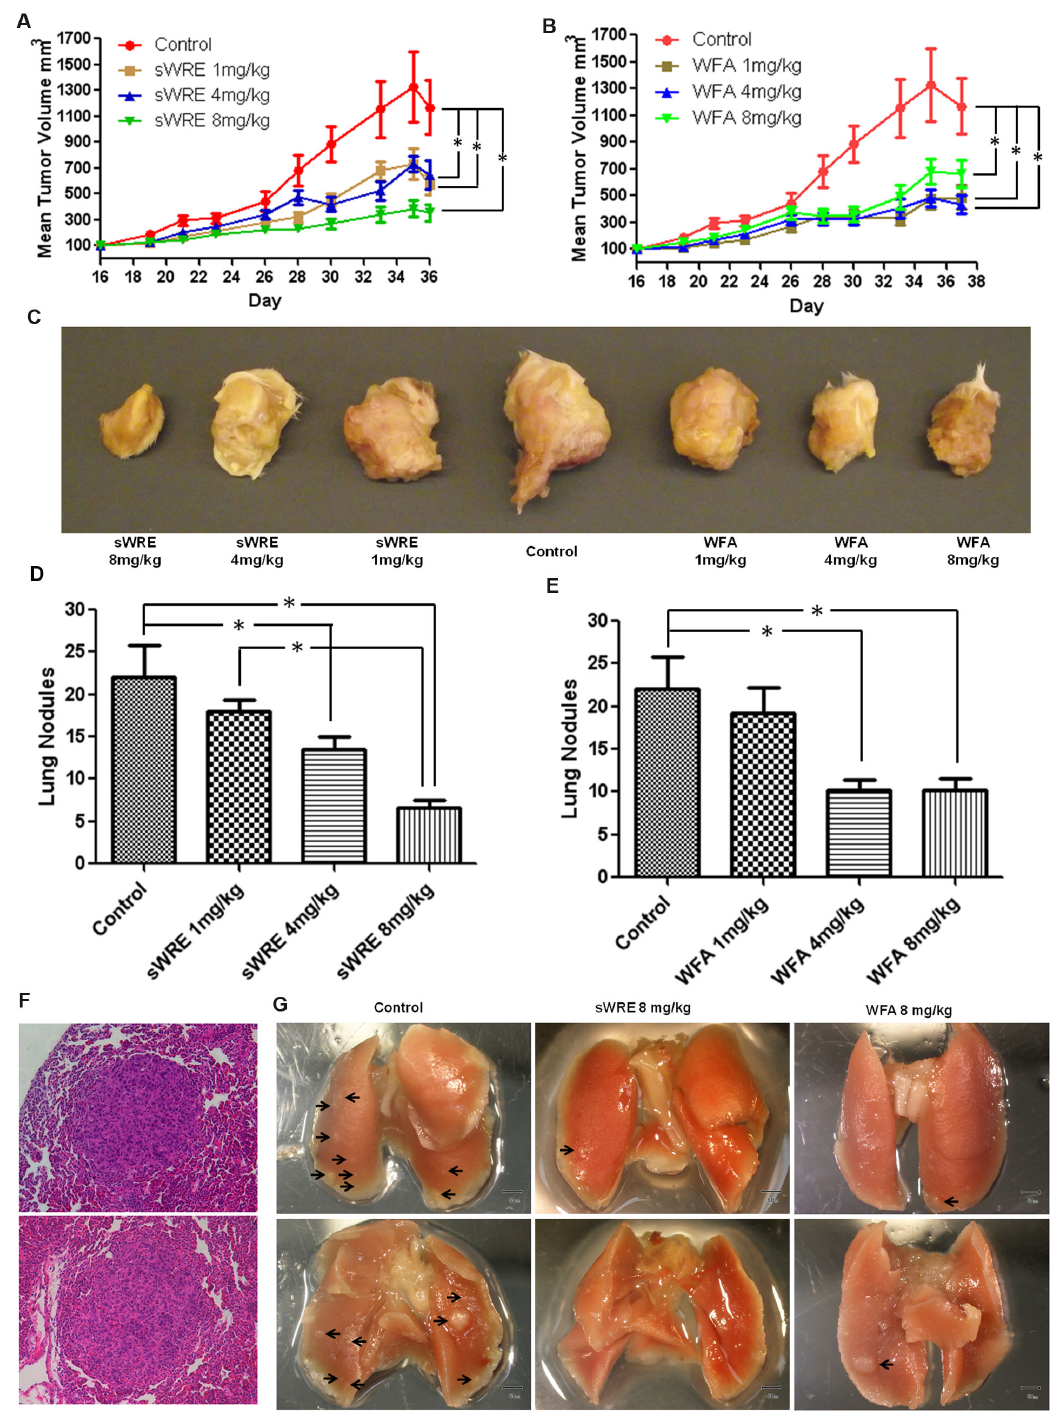
Figure 6. Anti-metastatic activity of sWRE and Withaferin A in an allograft breast cancer mouse model. (A and B) Mean tumor volume in mice treated with 1, 4, 8mg/kg of (A) sWRE or (B) Withaferin A (WFA) (* p<0.05 compared to control). (C) Representative images of the primary tumor in sWRE or WFA treated mice. (D and E) Bar graph showing the mean number of metastatic lung nodules in (D) sWRE or (E) WFA-treated mice (* p<0.05 compared to control). (F) Representative H&E staining images showing the histology of metastatic nodules in mouse lung; two examples shown. (G) Representative images of lung metastatic nodules (black arrows) in mice treated with vehicle control (9% EtOH) or sWRE or WFA at 8mg/kg. doi: 10.1371/journal.pone.0075069.g006 PLOS ONE |